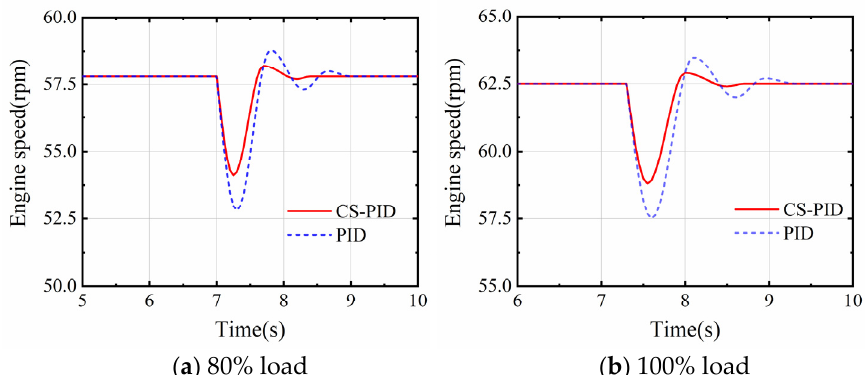
Figure 11. Comparison of engine speed response curves.